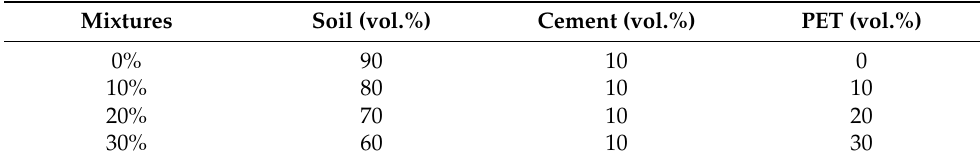
Table 1. Compositions (vol.%) of the soil-cement mixtures.